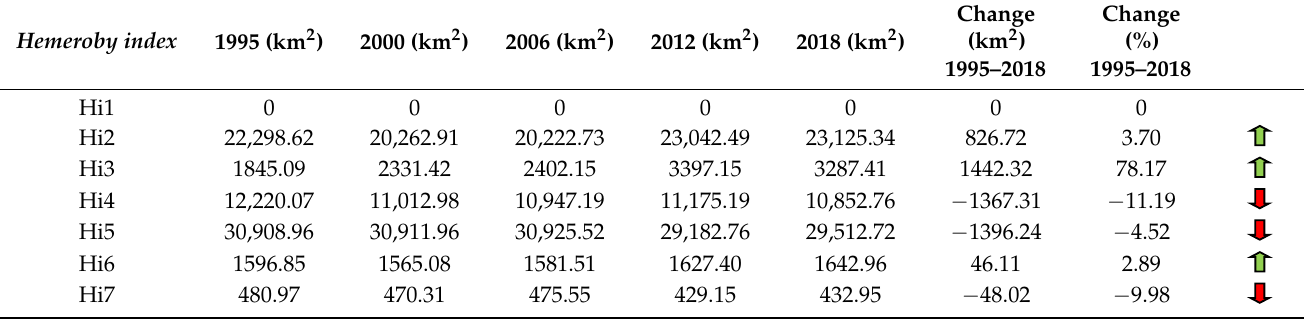
Table 4. Land cover naturalness changes in Lithuania, 1995–2018. Hi1–Hi7 indicates the degree of naturalness (hemeroby index; according to Table 1) according to CORINE data. There are no recorded areas with hemeroby index Hi1 (i.e., no completely natural sites). An upward green arrow indicates an increase in land cover between 1995 and 2018, while a downward red arrow indicates a decrease in land cover.